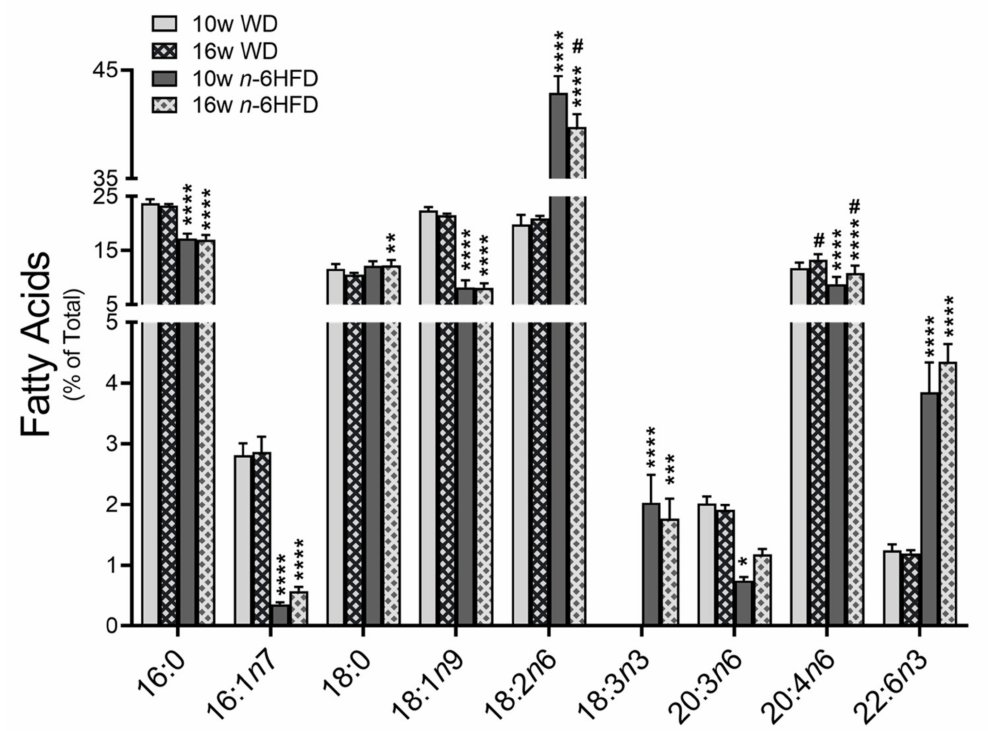
Figure 2. Plasma fatty acid profile in C57BL/J6 male mice fed the WD or n -6HFD through 10 and 16 weeks of age. Bars represent average percentage values + SD of total plasma fatty acids ( n = 5 for each diet at 10 and 16 weeks) for 16:0 palmitic acid; 16:1 n 7 palmitoleic acid; 18:0 stearic acid; 18:1 n 9 oleic acid; 18:2 n 6 linoleic acid; 18:3 n 3 α -linolenic acid; 20:3 n 6, dihomo- γ -linolenic acid; 20:4 n 6 arachidonic acid; and 22:6 n 3 docosahexanoic acid. Data represent mean ± SD; * p < 0.05, ** p < 0.01, *** p < 0.001, and **** p < 0.0001 represent statistically significant differences between WD and n -6HFD from the same time point; # p < 0.01 represents significant differences between time points with the same